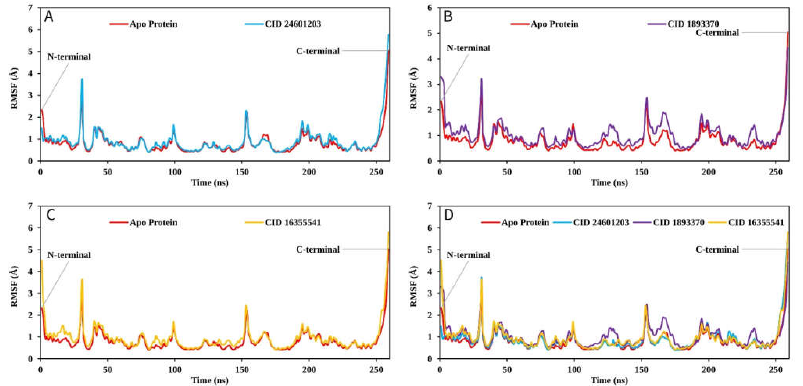
Figure 9. The RMSF values extracted for the Cα atoms of the five selected compounds in complex with the FAK1 protein (red) in complex with the compounds ( A ) CID: 24601203 (blue), ( B ) CID: 1893370 (purple), ( C ) CID: 16355541 (yellow) and ( D ) shows the RMSF for all compounds and the protein together. 2.9.3. Protein–Ligand Contacts The bonding relationship between the compounds and the target protein is crucial in terms of stability and PK characteristics. For example, molecular hydrogen bonding influ- ences drug selectivity, adsorption, and metabolism. As a result, a simulation interaction diagram was used to study the protein complex with the selected ligands and their inter- molecular interactions (SID). Figure 10 depicts the interactions that occur for more than 30.0% of the simulation duration between the natural compound (CID: 24601203, CID: 1893370, and CID: 16355541) atoms and the FAK1 protein residues and are characterized by hydrogen, hydrophobic, ionic, and water bridge linkages. Figure 10 also includes a stacked bar chart representation of the protein–ligand interactions discovered during the 100 ns simulation run. An interaction fraction value (IFV) can be used to describe the in- teraction between the protein and the ligands. For example, an IFV value of 0.7 indicates that the specific interaction is maintained for 70% of the simulation duration. Because some protein residues may make several interactions of the same subtype with the ligand, values greater than 1.0 (>100%) are feasible. The ARG side chain, for example, has four H- bond donors that can form four hydrogen bond interactions with a single H-bond accep- tor.